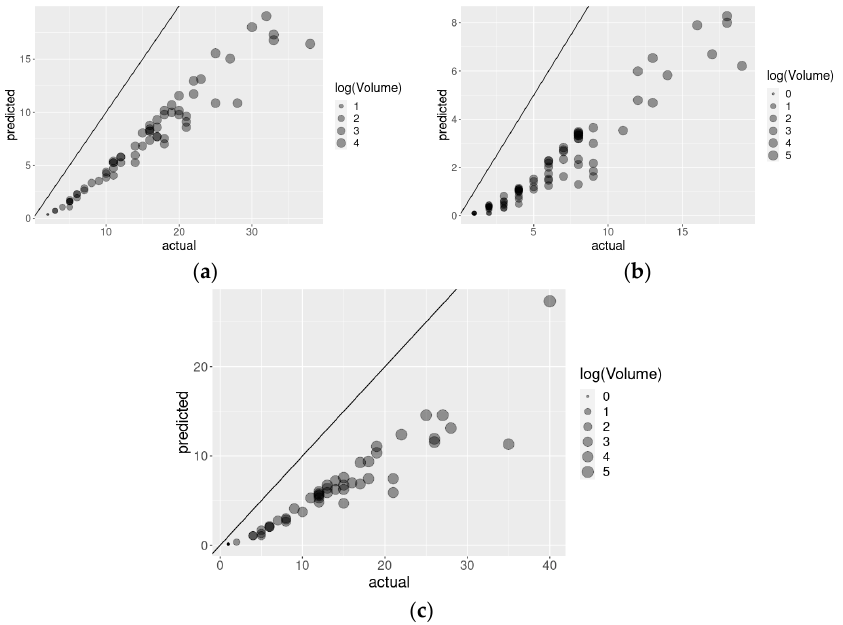
Figure 5. Bubble plots where predicted ( a ) mis-, ( b ) over-, and ( c ) under-utilization counts ( y -axis) are plotted against the actual values ( x -axis) from the Poisson rate regression models where each bubble represents the facilities for which the p -values are below 0.01 and with the size of each bubble representing the log volume of patients in the facility.